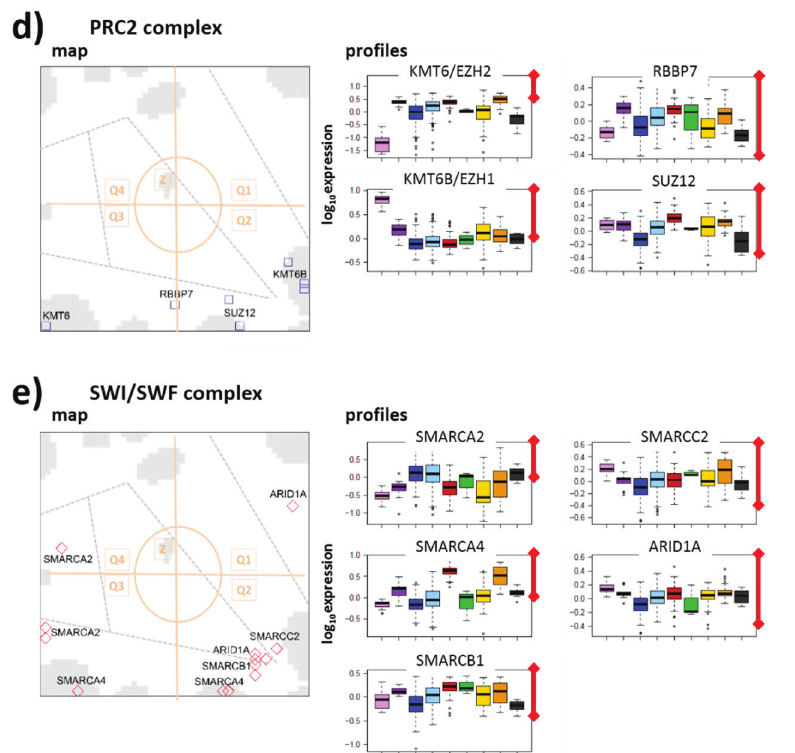
Figure 8. Map of ingredient-genes of chromatin modifying complexes: ( a ) overview map, ( b ) TrxG/MLL-, ( c ) PRC1-, ( d ) PRC2-, and ( e ) ATP-dependent chromatin remodeling SWI/SWF complexes,